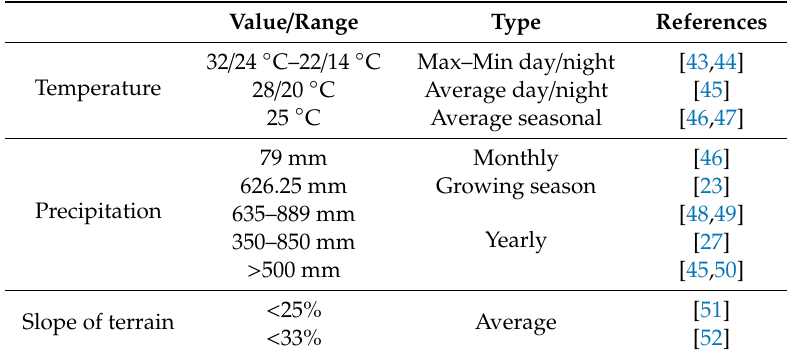
Table 2. Range of favorable climactic and topographic conditions for growing